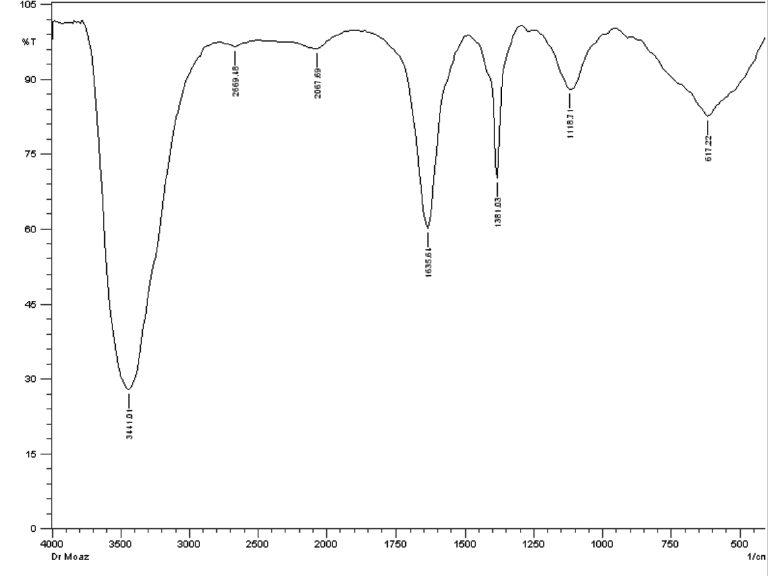
Fig. 10. FT-IR of crude extract of Streptomyces mutabilis M3 Table 5. Bio-flocculant activity of Streptomyces mutabilis M3 MT483919 extract for seawater treatment OD at 550 nm